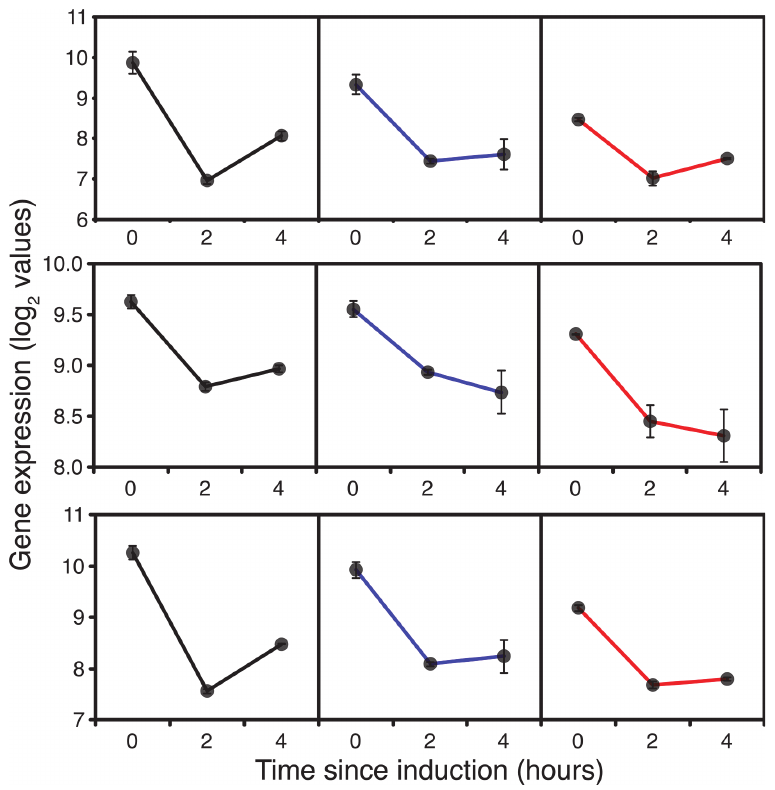
Fig 1. Expression of RNA polymerase I, II and III core function genes, 0 (before), 2 and 4 hours after the start of methanol addition to wild-type GS115 (black), TRY1-1 (blue) and TRY1-3 (red), strains containing 1 and 3 gene copies of the human typsinogen gene, respectively, under the control of the AOX1 promoter. From top to bottom, panels represent RPA1 , RPB2 and RPC2 . Error bars show SEM.